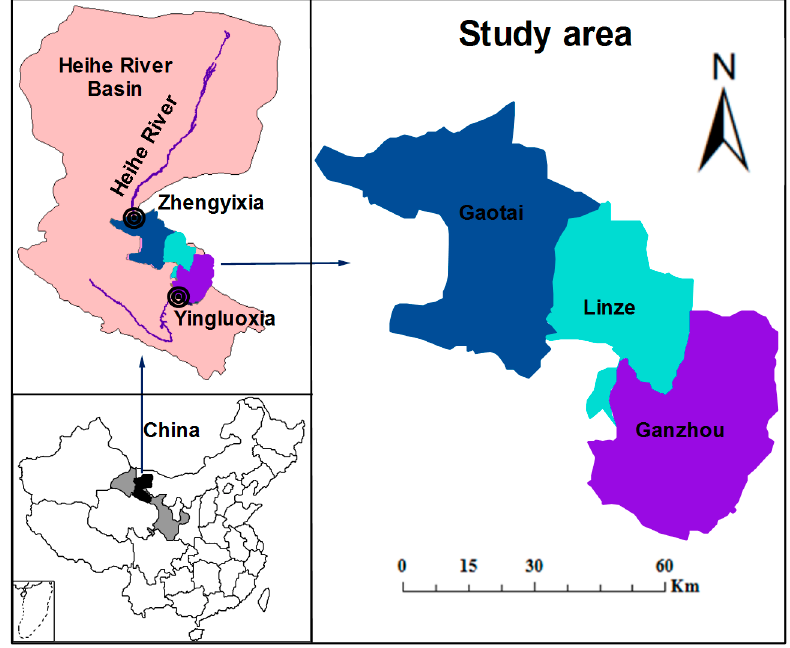
Figure 2. The study area.